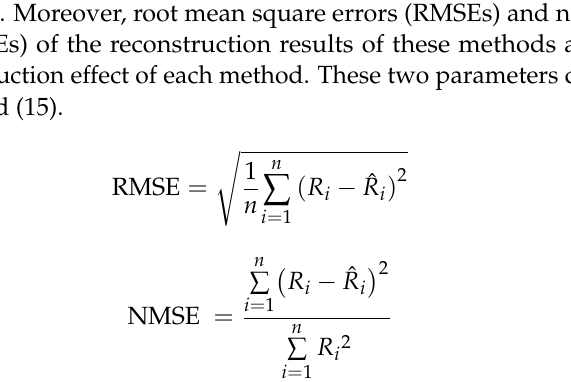
Figure 4. Reconstruction error of the Raman spectrum by several methods.